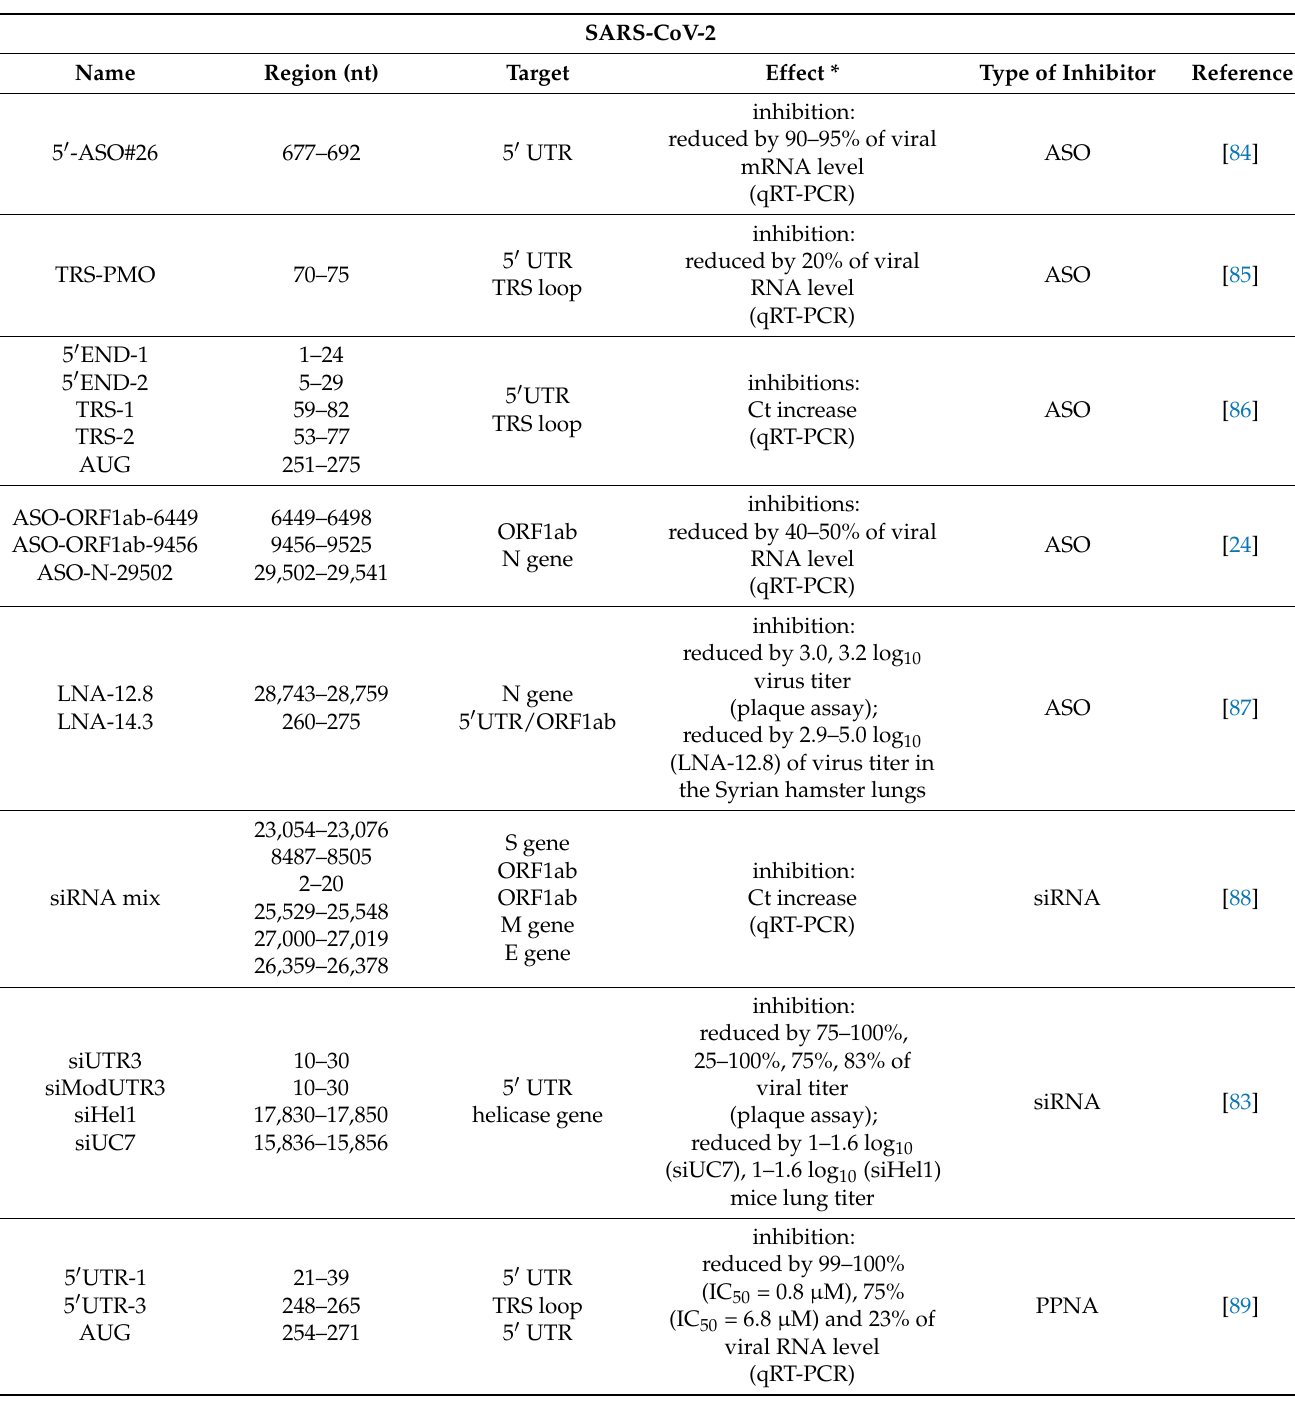
Table 1. RNA motifs of SARS-CoV-2 and IAV as a target of viral inhibitors. Selected inhibitors and theirs effect are listed. * the effect of inhibitors cannot be compared with each other because of different systems used in evaluations by different authors. Numbers listed are as authors wrote or, if not precise in text, are deducted from the publication’s figures. For better uniformity of presented results, it was decided to show the data from qRT-PCR of cell experiments (if conducted) for the best tested concentration of inhibitor. If qRT-PCR was not conducted, another measurement was presented for the best tested concentration. Main animal experiment results were additionally listed. The method of measurement was